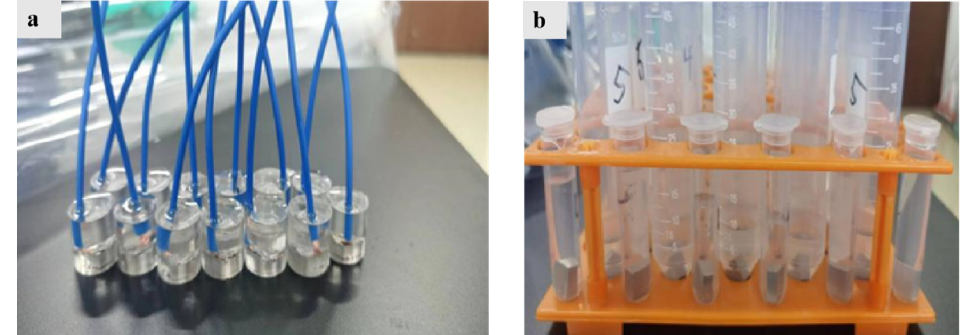
Figure 1. Test samples: ( a ) the electrode samples and ( b ) the micro samples.